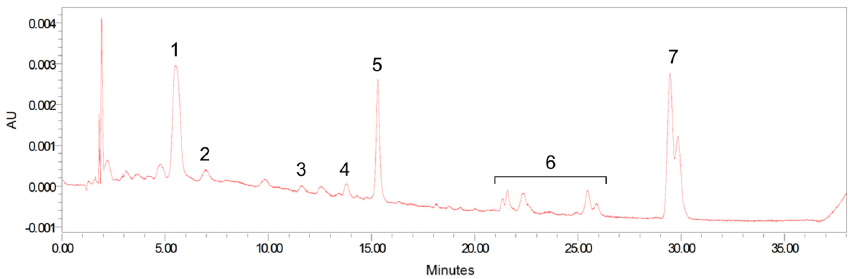
Figure 1. Representative high pressure liquid chromatography (HPLC) separation of carotenoids from serum. Peaks: 1, lutein; 2, zeaxanthin; 3, β‐ cryptoxanthin; 4, α‐ carotene; 5, β‐ carotene; 6, cis ‐ lycopene isomers; and 7, all ‐ trans lycopene plus 5 ‐ cis lycopene